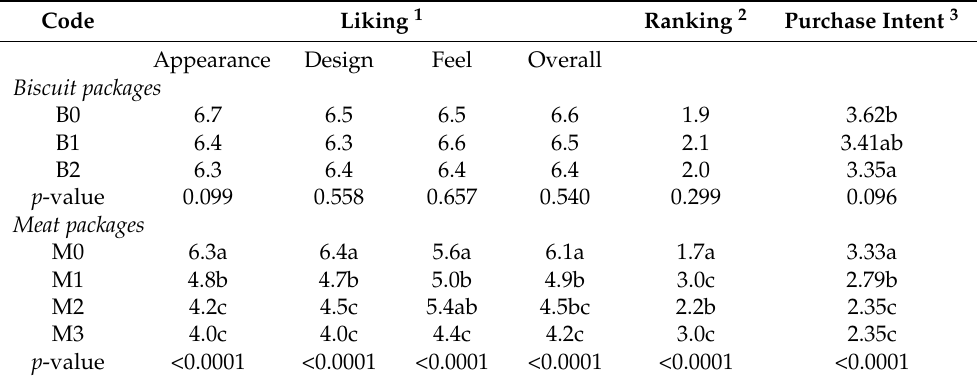
Table 5. Liking scores, preference ranking and purchase intent for biscuit and meat packages. Code